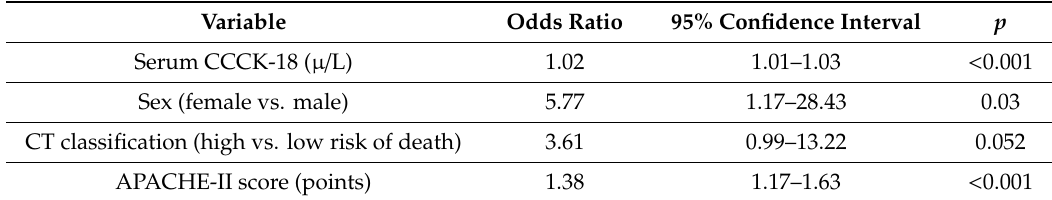
Table 3. Multiple logistic regression analysis to predict 30-day mortality. CT = computer tomography; APACHE = Acute Physiology and Chronic Health